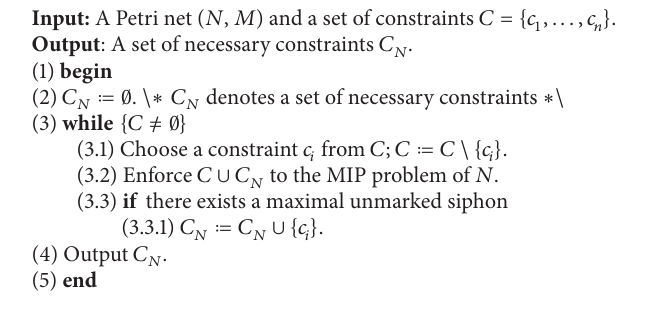
Algorithm 1: Extraction of necessary constraints.